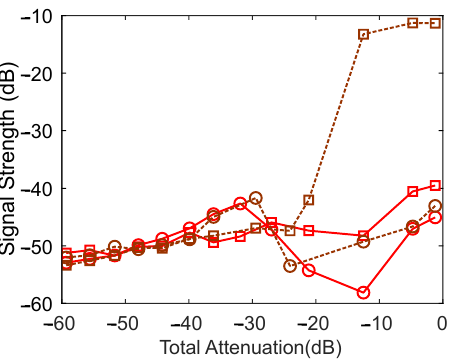
Figure 6. VCSEL (Dashed) and DFB (solid) SM signal strength vs. attenuation. Circles—displacement signal, squares—optically chopped